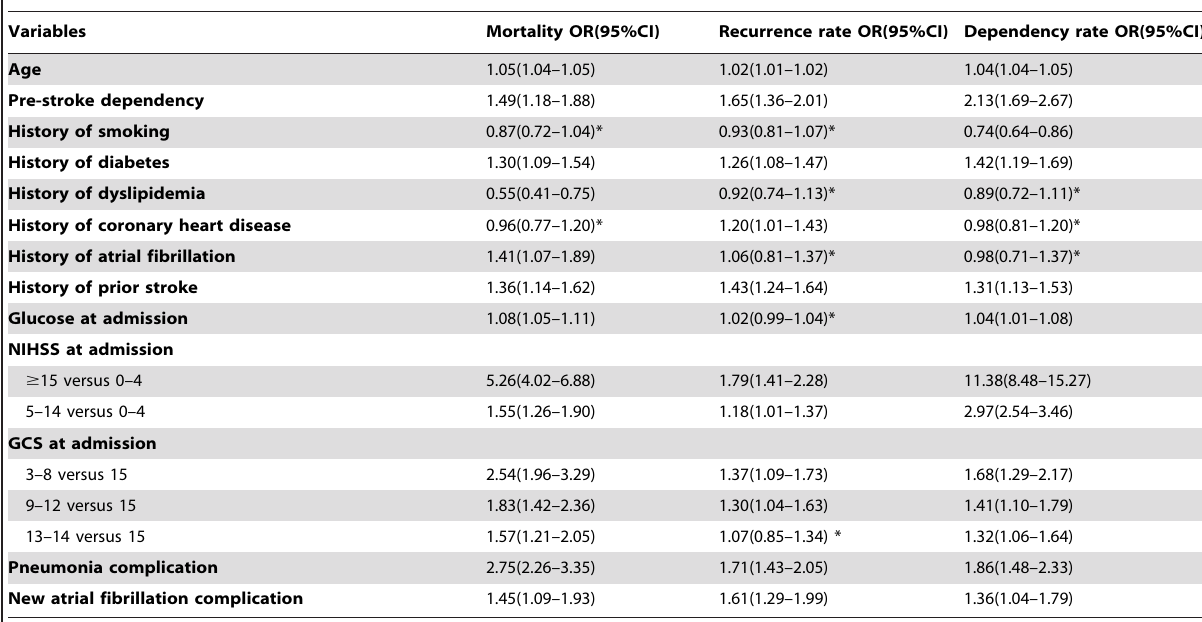
Table 4. Multivariate logistic regression analysis for confounders and outcomes at 12 months after stroke onset.